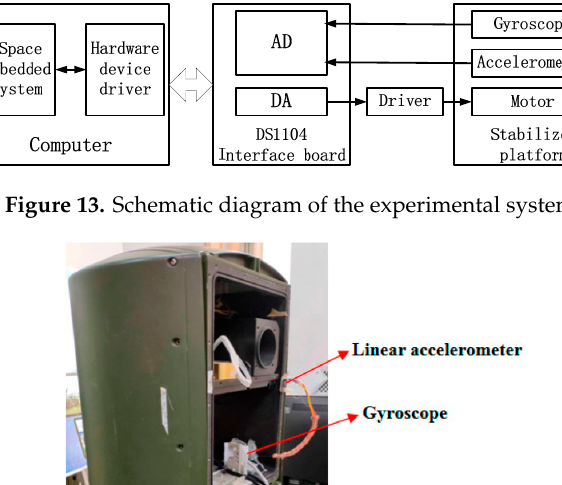
Figure 14. Diagram of the stable platform.